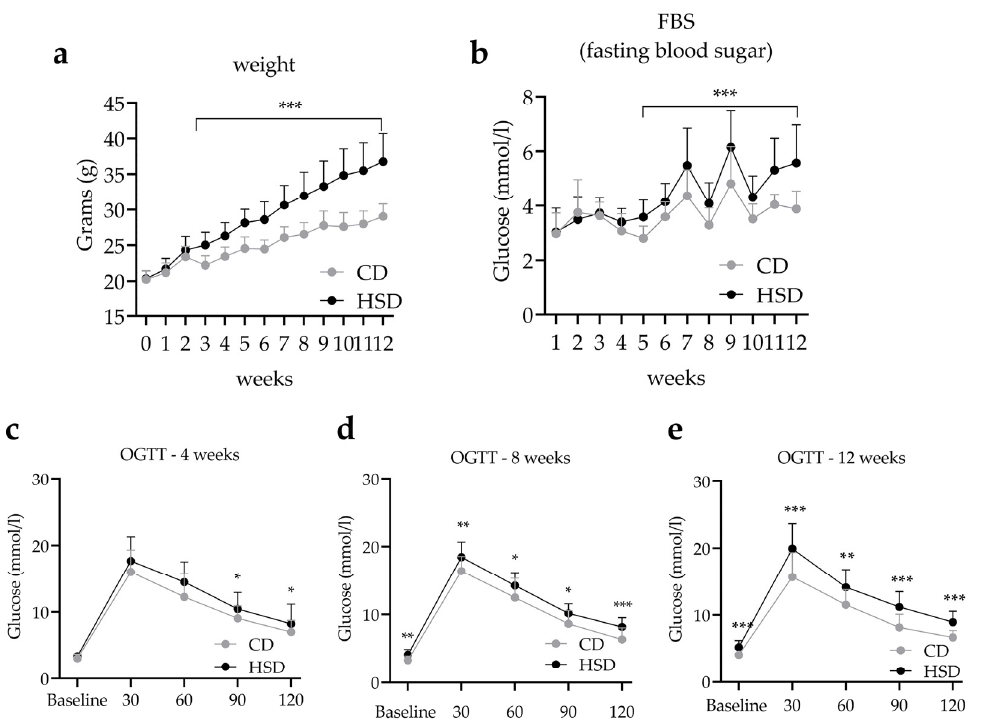
Figure 2. HSD exposure leads to bodyweight gain, glucose tolerance impairment, and hyperglycemia. ( a ) Bodyweight from 0–12 weeks of mice fed CD or HSD. ( b ) Fasting blood glucose of CD or HSD mice fed for 1–12 weeks. ( c – e ) Oral Glucose Tolerance Test (OGTT) of CD or HSD fed mice at weeks 4, 8, and 12. * p < 0.05, ** p < 0.01, *** p < 0.001. When compared with CD group, results are presented as the mean ± SD.